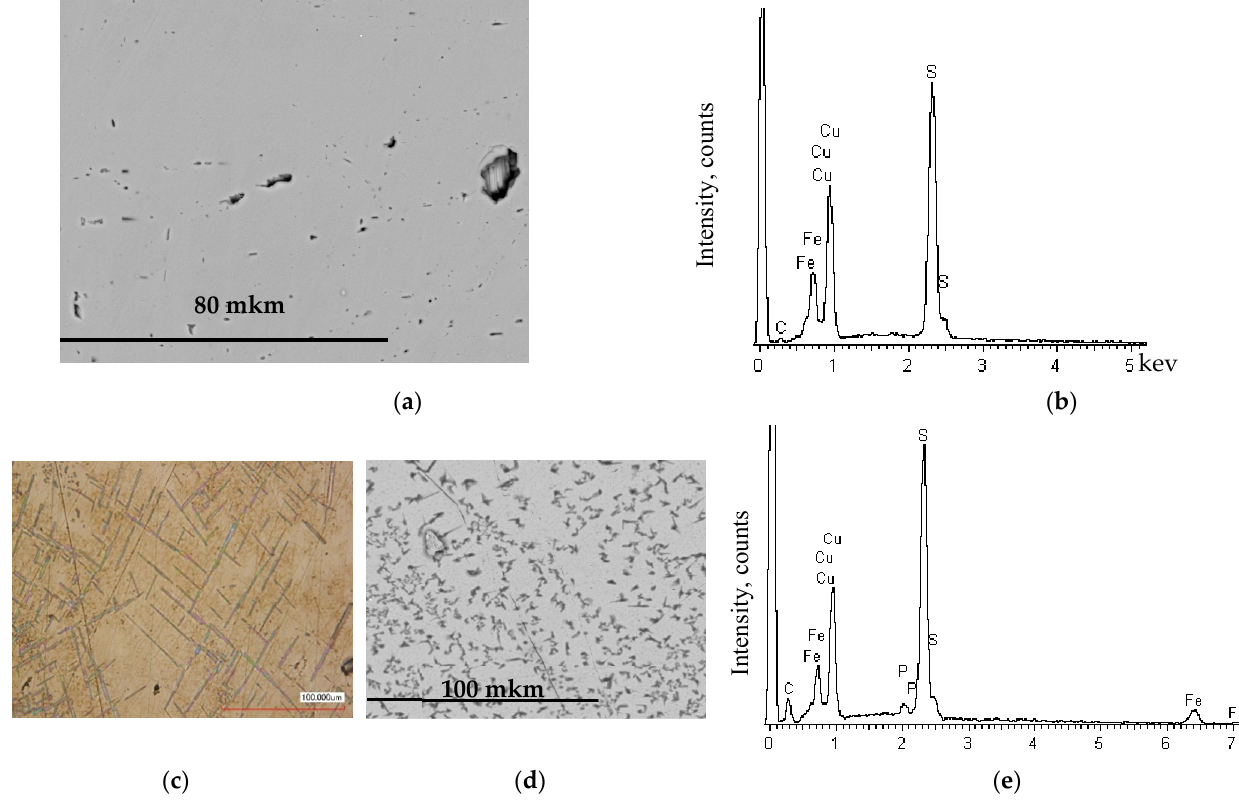
Figure 2. SEM image of the chalcopyrite surface ( a ) and energy-dispersive spectrum ( b ) before its contact with the CR; surface image of the chalcopyrite by laser scanning microscopy ( c ), SEM image ( d ); and energy-dispersive spectrum ( e ) after contact with the CR.